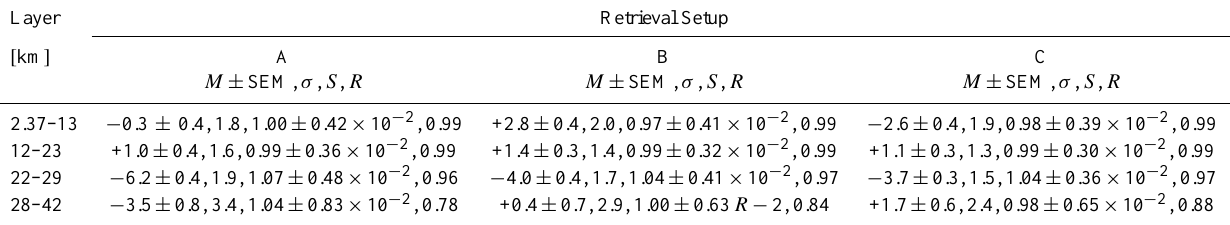
Table 5. Statistics of coincident measurements from the IFS 120/5HR and IFS 120M ozone partial columns for each setup and layer ( N = 19). Layer Retrieval Setup